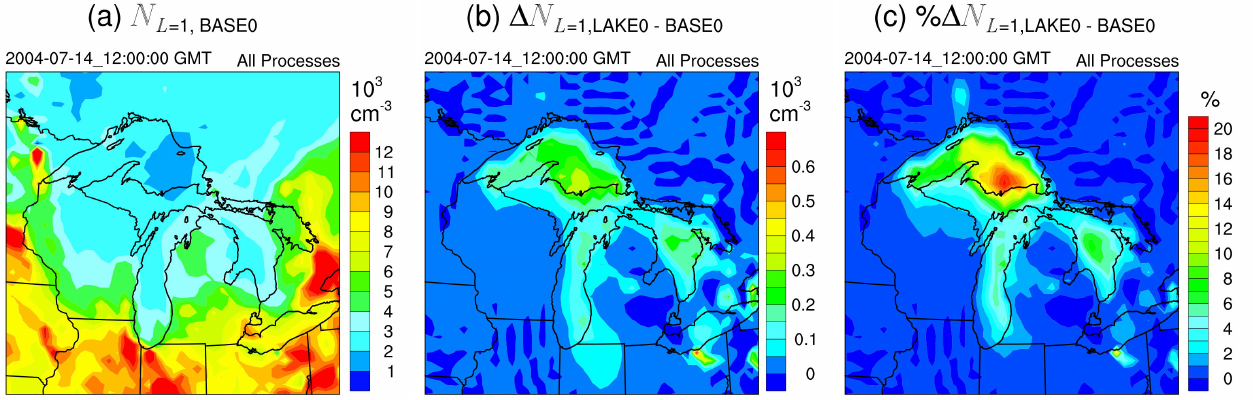
Fig. 3. Simulation results for 12:00:00GMT (8 am Eastern Daylight Time) on 14 July 2004 with all aerosol dynamical processes included: (a) surface-layer aerosol number concentrations (10 3 cm − 3 ) for the BASE0 case, (b) difference between LAKE0 and BASE0 cases, and (c) percent difference between LAKE0 and BASE0